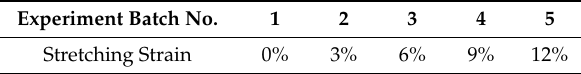
Table 1. Stretching strains of samples.